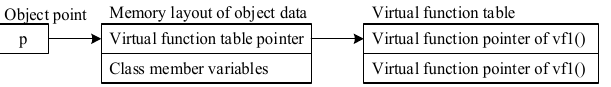
Figure A2. The general memory model of objects containing virtual table classes in C ++.